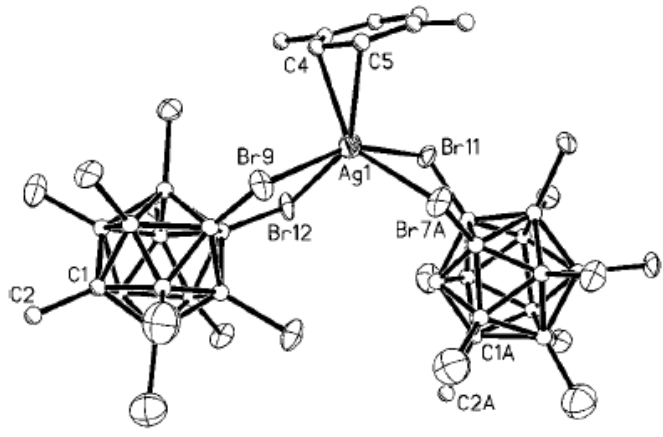
Figure 77. Fragment of X-ray structure of {Ag( η 2 - para -xylene)[1-Me-CB 11 HBr 10 ]} n . Reprinted with permission from reference [98]. Copyright © (1998) American Chemical Society.